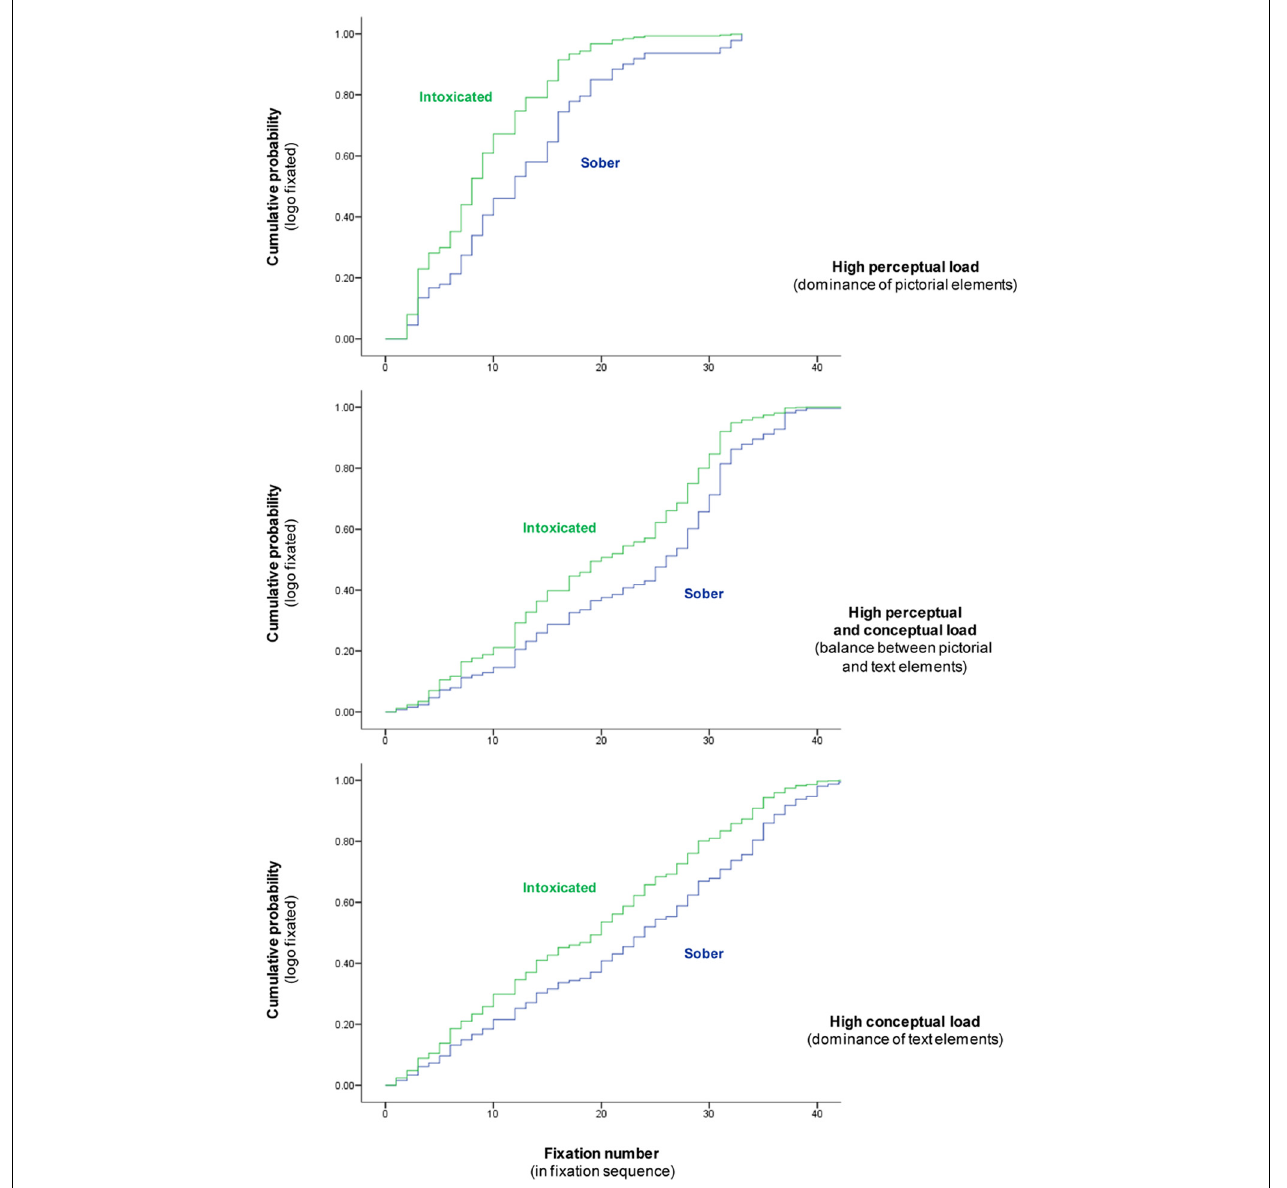
FIGURE 1 | Cumulative probabilities of fixating the logo for intoxicated participants (mean BAC = 0.102%, SD = 0.032) relative to sober participants.